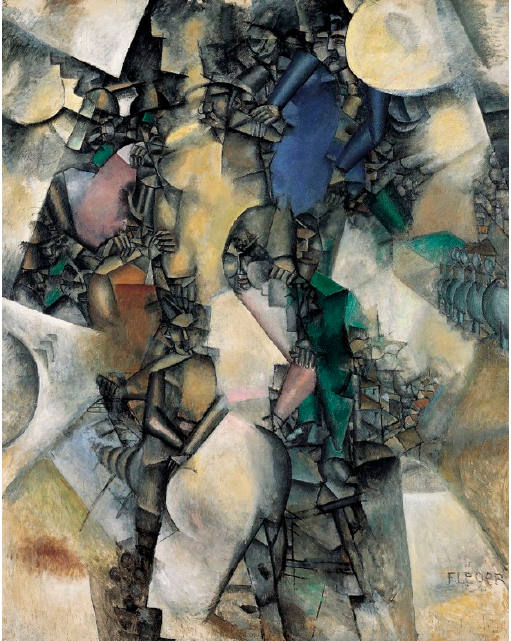
Figure 5. La Noce by Fernand Léger, 1912. Oil on canvas, 206 cm × 257 cm. Collection Centre Pompidou, Paris Musée National d’art Modern , Paris. Donation of M. Alfred Flechtheim in 1937. Used by